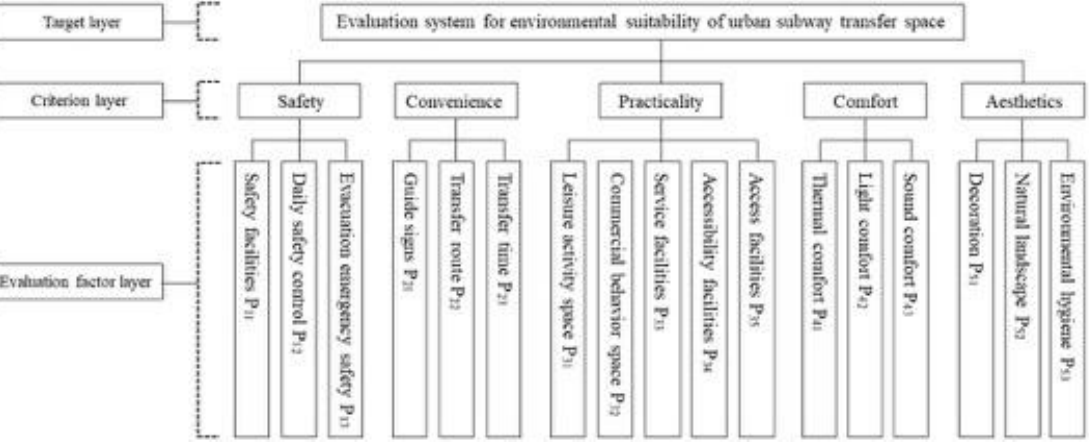
Figure 3. Evaluation model of the environmental suitability of transfer spaces in urban subway stations.